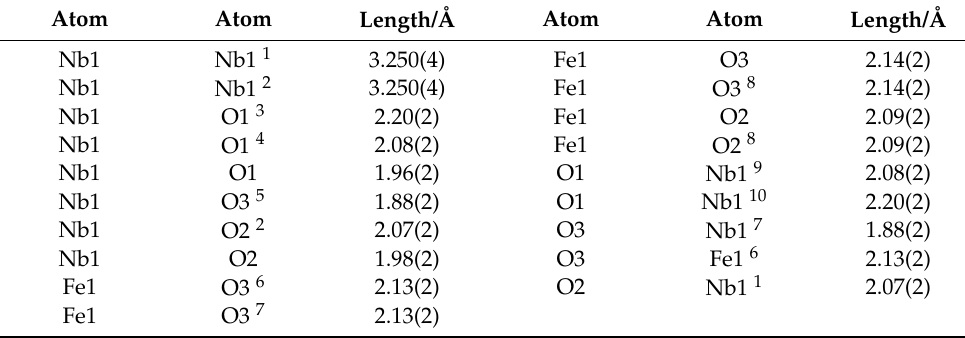
Table A4. Bond lengths for